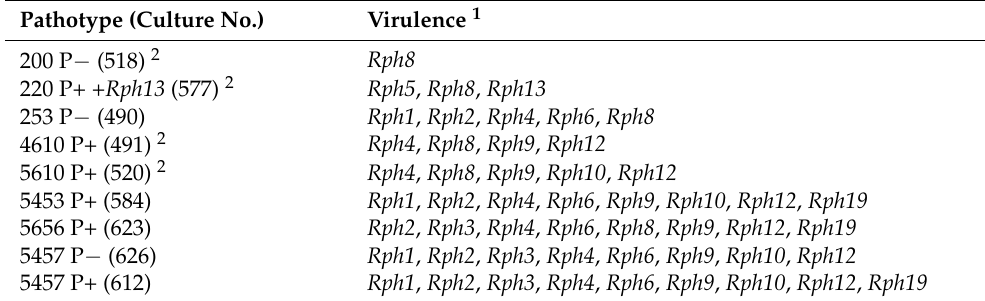
Table 3. Pathotypes of Puccinia hordei used in the present study and their virulence profiles with respect to specific Rph